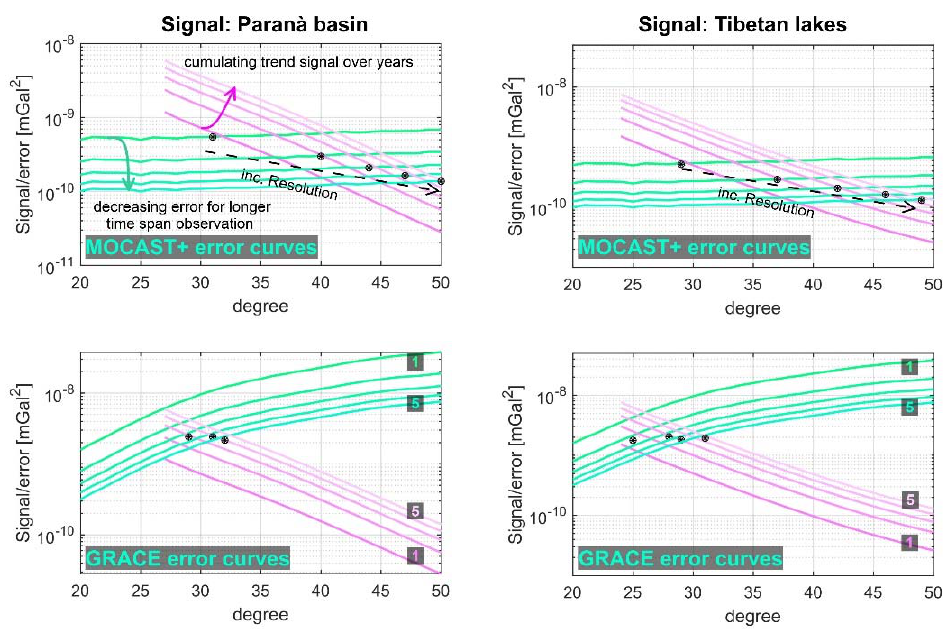
Figure 14. Improvement of spatial resolution as time span of mission increases: top—considering MOCAST+ error curves; bottom—considering GRACE. See text for details. Left—Paraná basin; right—Tibetan lakes. Spectra computed at 250 km altitude. Green-tinted curves: lowering of the error curves as the observation periods increase; Purple-tinted curves: signal cumulating over increasing time